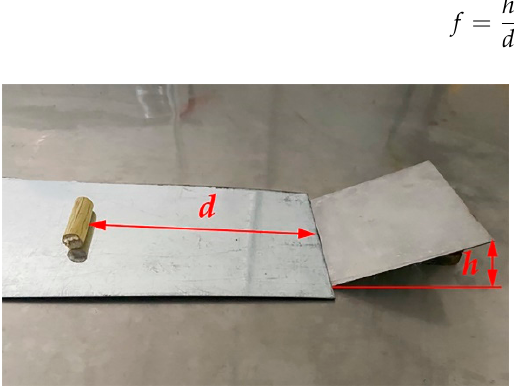
Figure 3. Platform to test the roll friction coefficient.